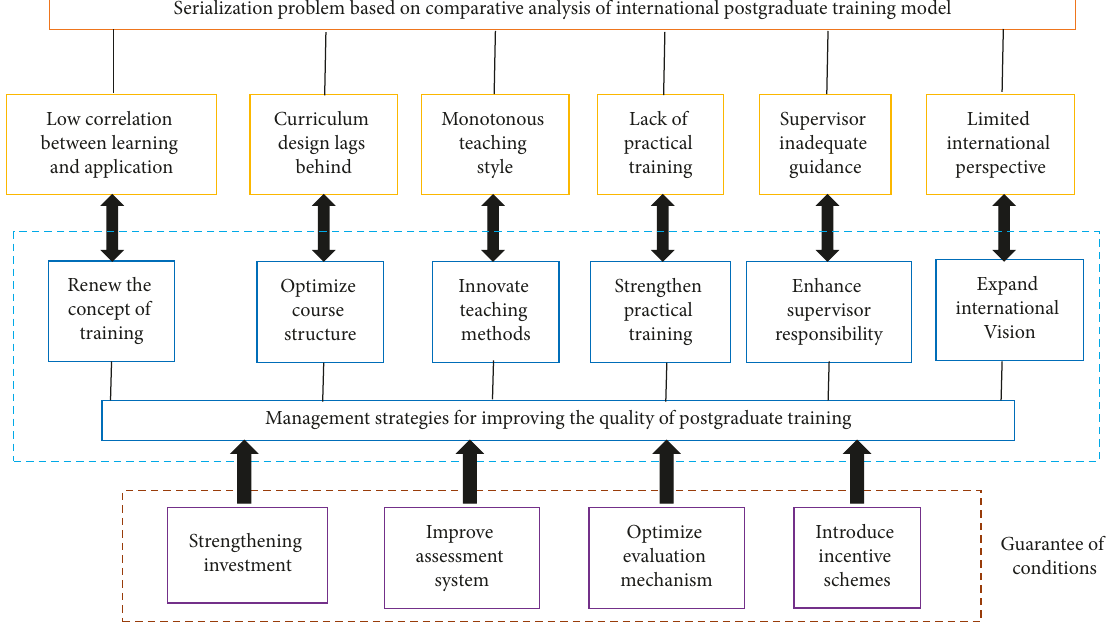
Figure 1: Frame diagram of the overall theoretical system of postgraduate education quality improvement